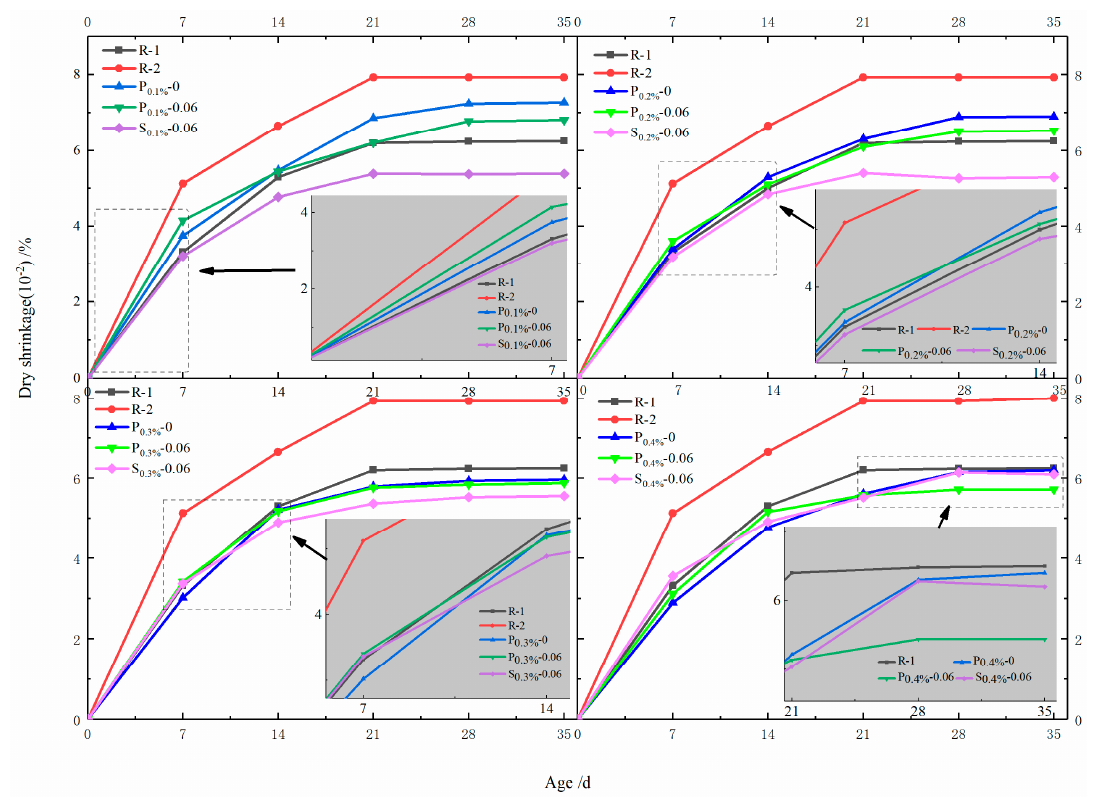
ff erent adding methods of